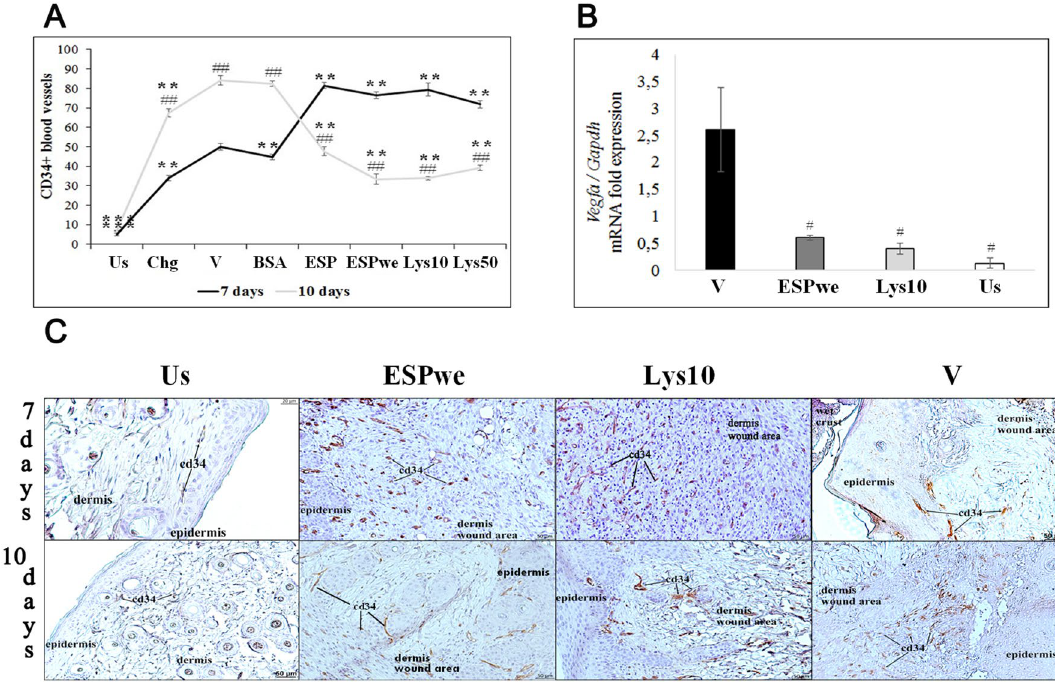
mean ± SEM, **p < 0.01 as compared to a vehicle, ## p < 0.01 as compared to previous study period.; ( B ) Vegfa compared to unwounded skin, # p ≤ 0.05 as compared to a vehicle; ( C ) CD34 + staining for newly formed